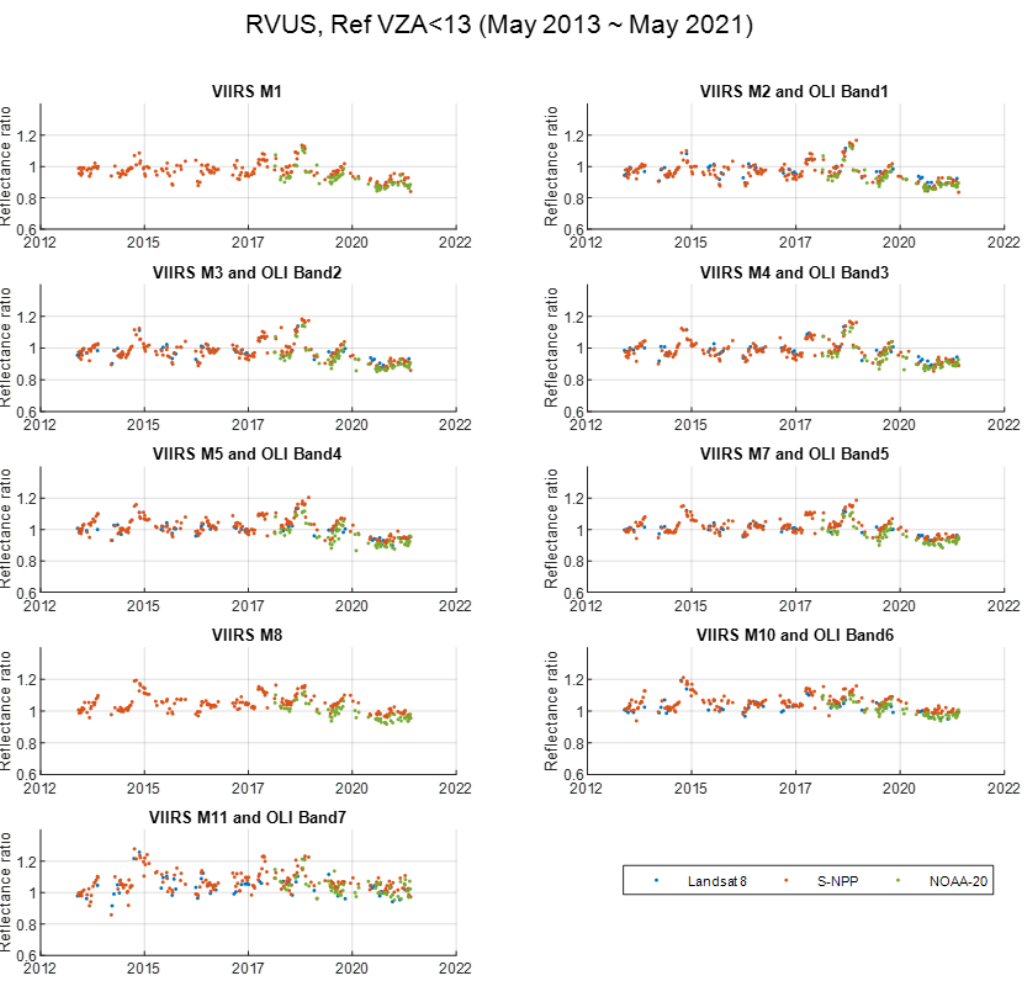
Figure 4. The time series of the reflectance ratio between RadCalNet with Landsat-8/OLI, operational SNPP/VIIRS, and NOAA-20/VIIRS over RVUS from May 2013 to May 2021.